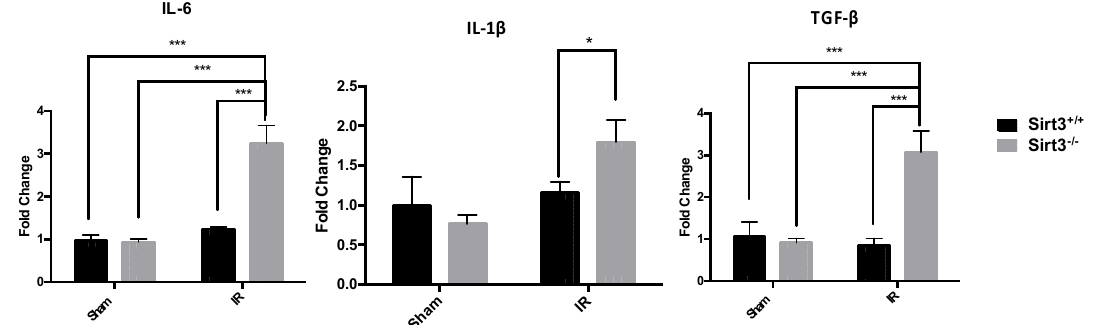
Figure 3. Expression of inflammatory markers determined by quantitative real-time PCR. IL6 and TGF β were significantly increased in Sirt3 − / − mice after irradiation compared to sham irradiated Sirt3 +/+ or Sirt3 − / − as well as Sirt3 +/+ irradiated groups. IL1 β was significantly increased in irradiated Sirt3 − / − mice compared to irradiated Sirt3 +/+ livers ( n = 4–6; * p < 0.05, *** p < 0.001). 3.2. The Number of Bile Ducts Was Decreased in Irradiated Livers of Sirt3 − / −